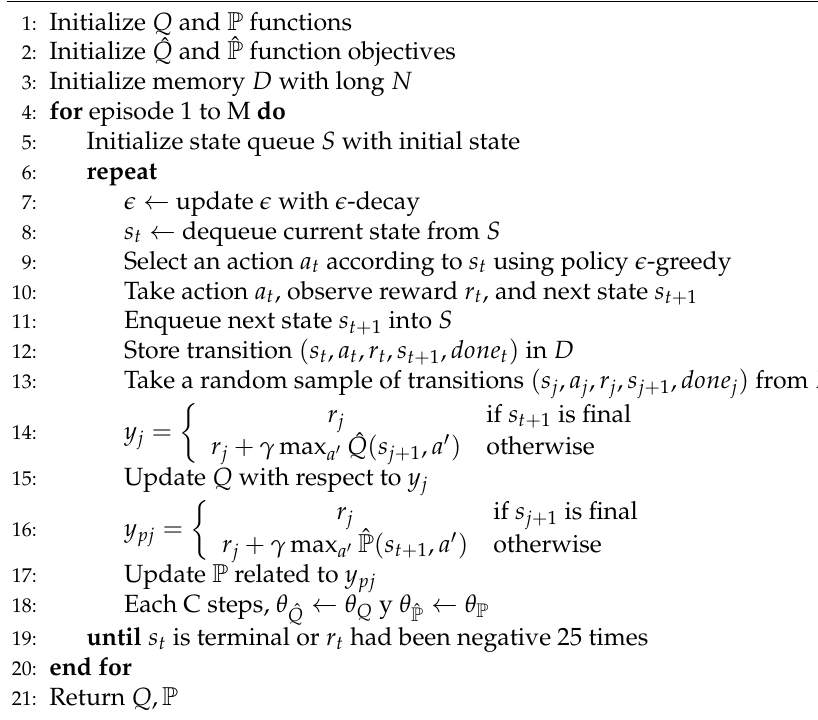
Algorithm 1 Explainable goal-driven learning approach to calculate the probability of success using the learning-based method.